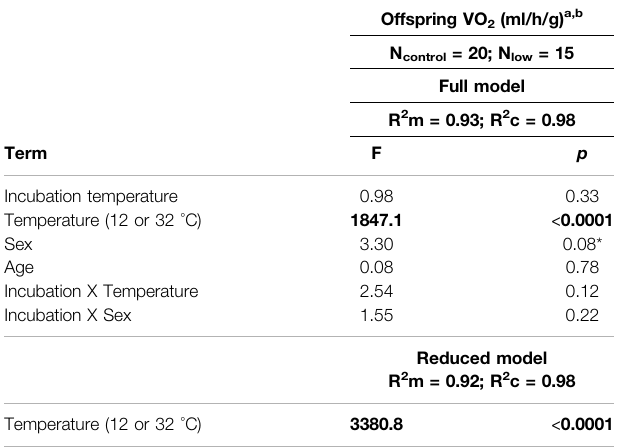
Bold values indicate statistical signi fi cance and asterisks (*) indicate marginal signi fi